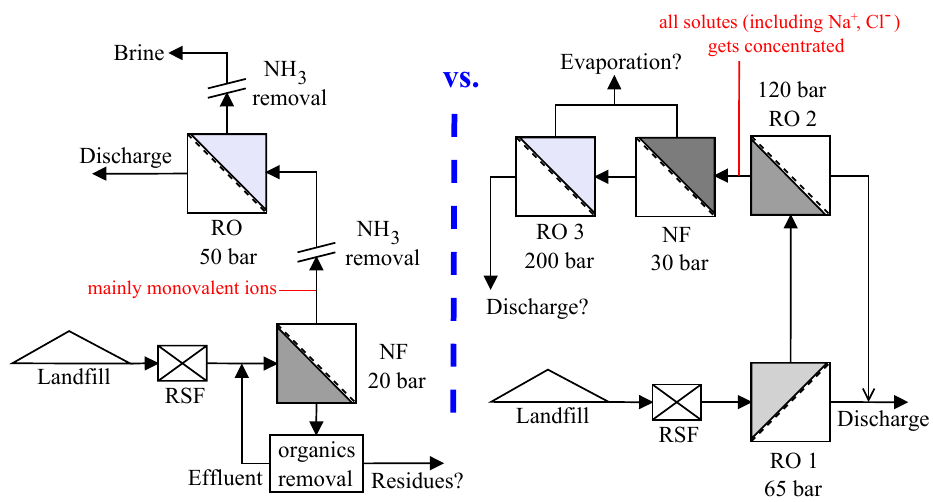
Figure 5. Comparison of: NF-RO—plausible operating pressures and perspectives on integration options ( left ); and process chain at the landfill site for leachate treatment using RO-NF ( right ).